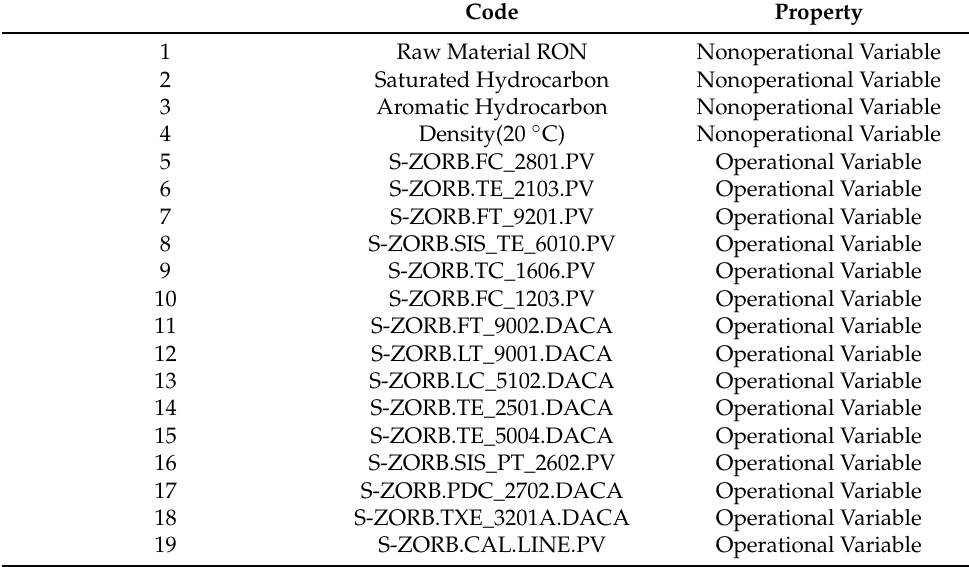
Table 4. Main RON